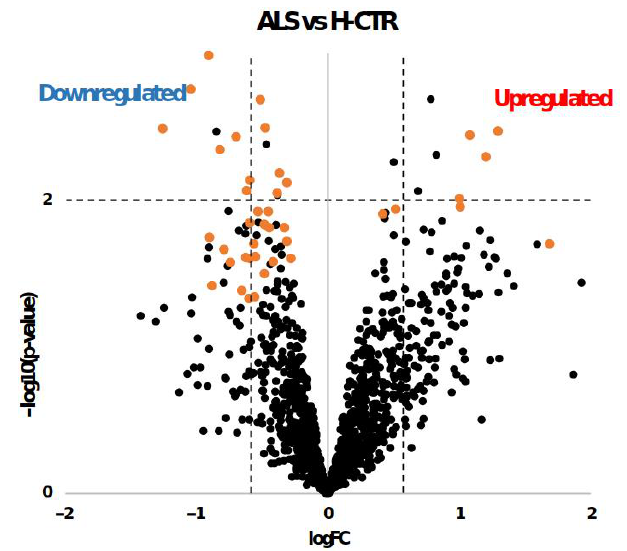
Figure 2. Volcano plot of log2 fold change (logFC) vs. log10 transformed p -values ( − log10 ( p -value)) for each protein in ALS patients compared with H-CTR. The x axis represents the logarithm (base 2) of the fold change between the two conditions. The fold change is the ratio between sample means of the two groups. Proteins with p -values less than 0.01 appear at the top of the plot above the horizontal dashed line. The vertical dashed lines indicate the thresholds of ± 1.5-fold change. Significantly differentially expressed proteins obtained by SAM analysis are labeled with orange